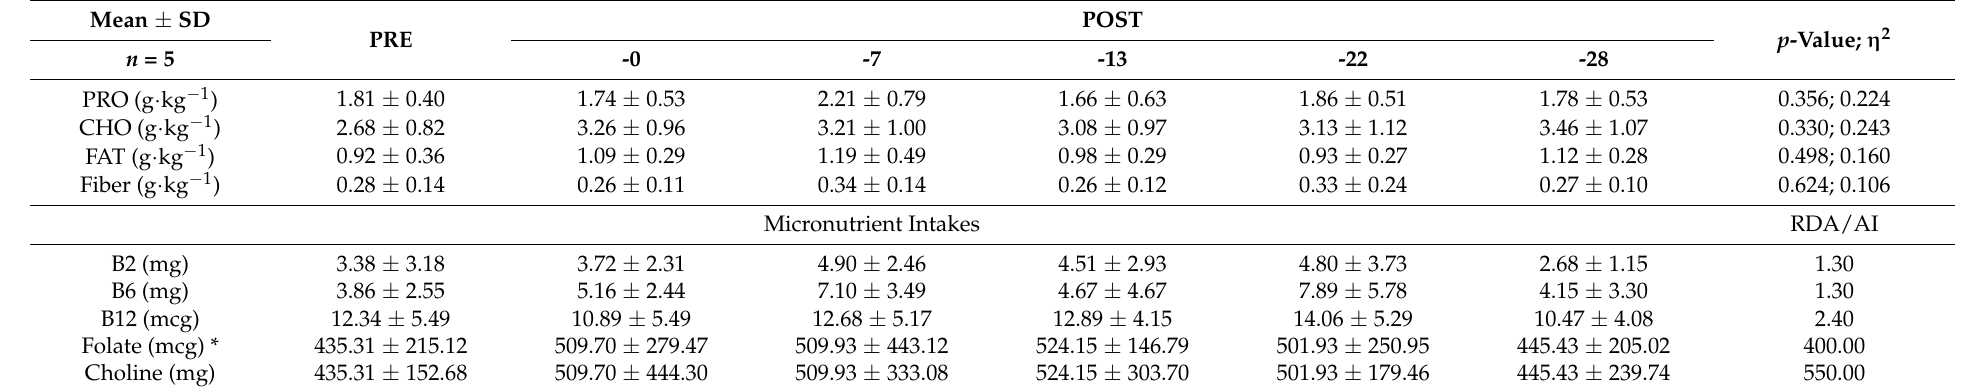
CHO = carbohydrate; PRO = protein. * Folate listed is dietary folate equivalent. All micronutrient dietary intake standards are based on current (2020–2025) recommendations for males aged 19–30 years. In brief, no dietary changes were evident throughout the investigative